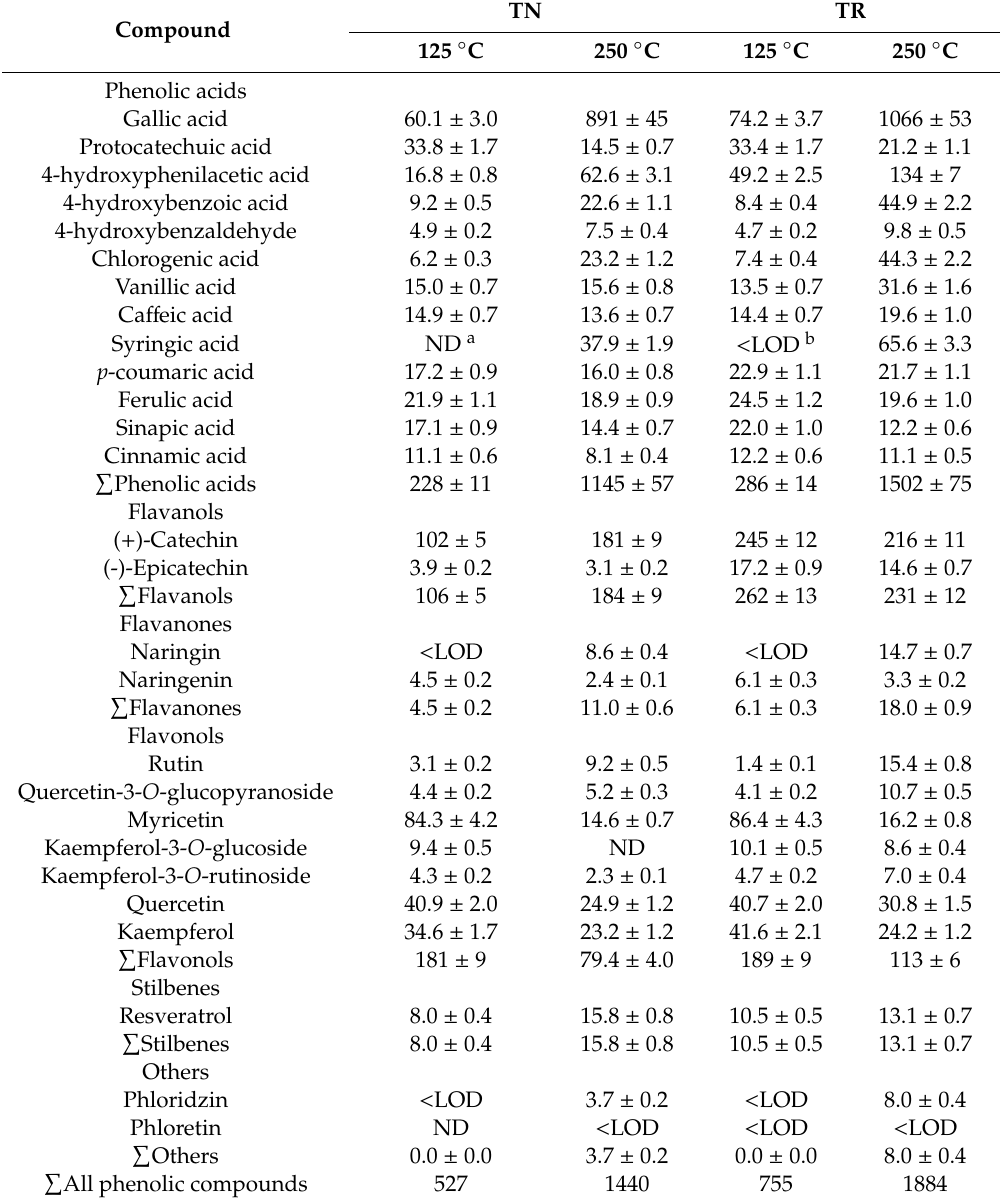
Table 2. Content of the identified phenolic compounds in Touriga Nacional (TN) and Tinta Roriz (TR) extracts obtained through subcritical water extraction (SWE) at 125 and 250 ◦ C. Results were expressed as mean ± standard deviations (milligrams of compound / 100g dw, n =